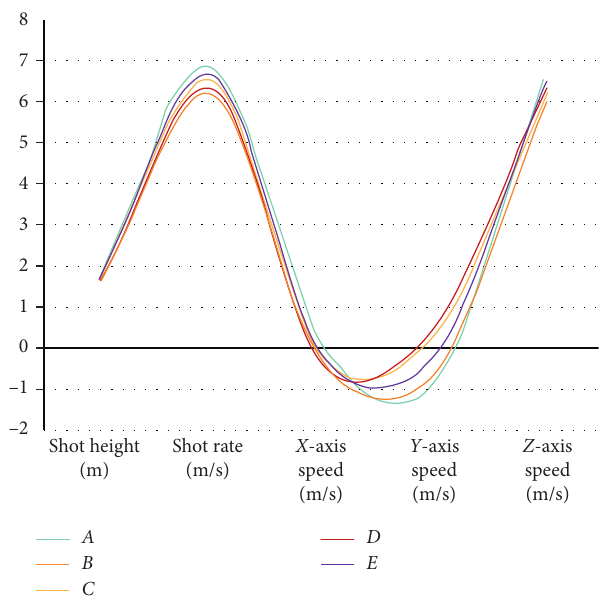
Figure 7: Statistical diagram of the position of the shot of the top